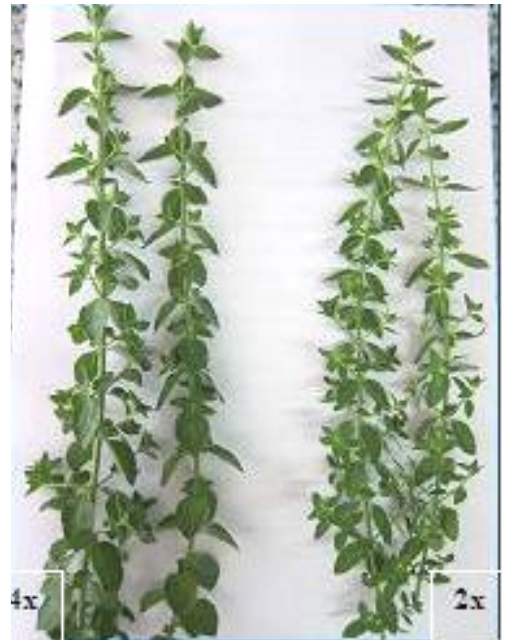
Fig. 7. Morphological changes between diploid (right) and tetraploid (left) Iranian